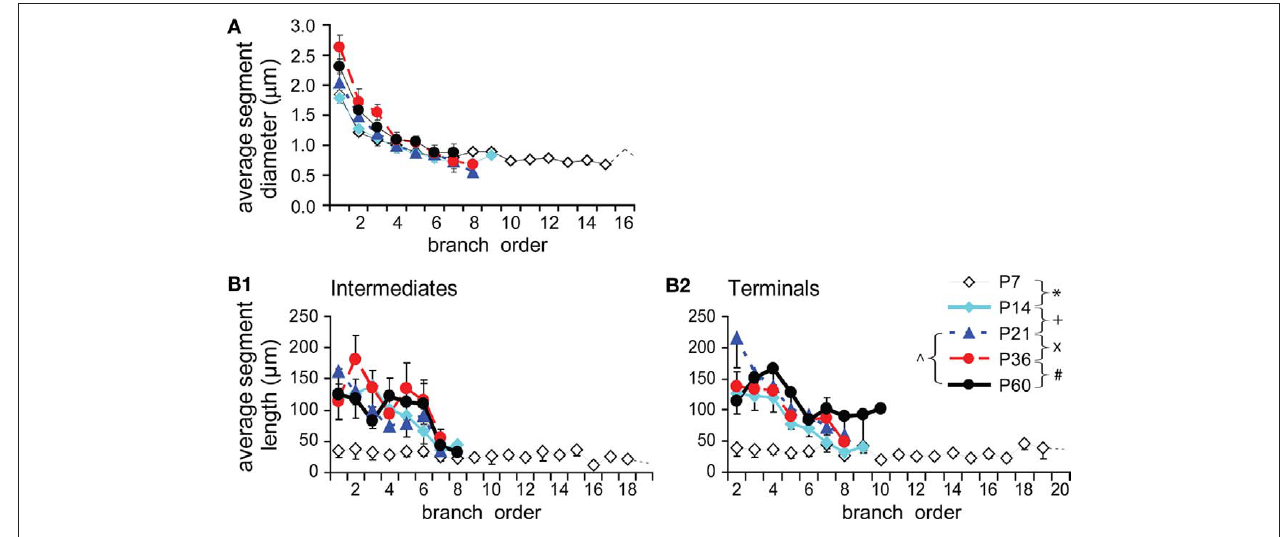
order. There were no significant changes in both intermediates and terminals. However, the variation at each plot is large. Note at P7 due to filopodia-like segments, the branch orders were markedly higher than those at older ages, resulting in overall shorter average segment lengths (referring to Figure 7A